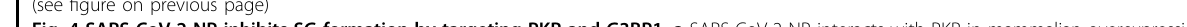
Fig. 4 SARS-CoV-2 NP inhibits SG formation by targeting PKR and G3BP1. a SARS-CoV-2 NP interacts with PKR in mammalian overexpression system. HEK293T cells (5 × 10 6 ) were transfected with the indicated plasmids for 24 h. The cell lysates were added with poly(I:C) (8 μ g) or left untreated. Co-immunoprecipitation and immunoblot analysis were performed with the indicated antibodies. b Association of SARS-CoV-2 NP with endogenous PKR. HEK293T cells (5 × 10 6 ) were transfected with SARS-CoV-2 NP-HA plasmid (10 μ g) for 24 h. Cell lysates were left untreated or mixed with poly(I:C) (8 μ g) or treated by RNase A. Co-immunoprecipitation and immunoblot analysis were performed with the indicated antibodies. c Effects of SARS-CoV-2 NP on poly(I:C)-induced PKR oligomerization and phosphorylation of PKR and eIF2 α . HEK293T cells (5 × 10 6 ) were transfected with control or SARS-CoV-2 NP-Flag plasmid (10 μ g) for 24 h, and then further transfected with poly(I:C) (8 μ g) for another 4 h. Cell lysates were separated by native- or SDS – PAGE as indicated and analyzed by immunoblot with the indicated antibodies. d Effects of SARS-CoV-2 NP on sodium arsenite-induced phosphorylation of eIF2 α . HEK293T cells were transfected with control or SARS-CoV-2 NP-Flag plasmid for 20 h and then treated with sodium arsenite (1 mM) or left untreated for 1 h before immunoblot analysis with the indicated antibodies. e Association of SARS-CoV-2 NP with endogenous G3BP1. HEK293T cells (5 × 10 6 ) were transfected with SARS-CoV-2 NP-HA plasmid (10 μ g) for 20 h. Co-immunoprecipitation and immunoblot analysis were performed with the indicated antibodies. f Effects of NP truncations on poly(I:C)-induced phosphorylation of PKR and eIF2 α . HEK293T cells were transfected with indicated plasmids for 12 h, and then transfected with poly(I:C) (2 μ g) for 10 h before immunoblot analyses were performed with the indicated antibodies. g Effects of NP truncations on poly(I:C)-induced SG formation. HeLa cells were transfected with indicated plasmids for 12 h, then transfected with poly(I:C) (2 μ g) for 10 h. Cells were immunostained for Flag-tagged NP truncations (green) and G3BP1 (red). Nuclei were stained with DAPI (blue). The cells were observed with a Nikon confocal microscope under a 60× oil